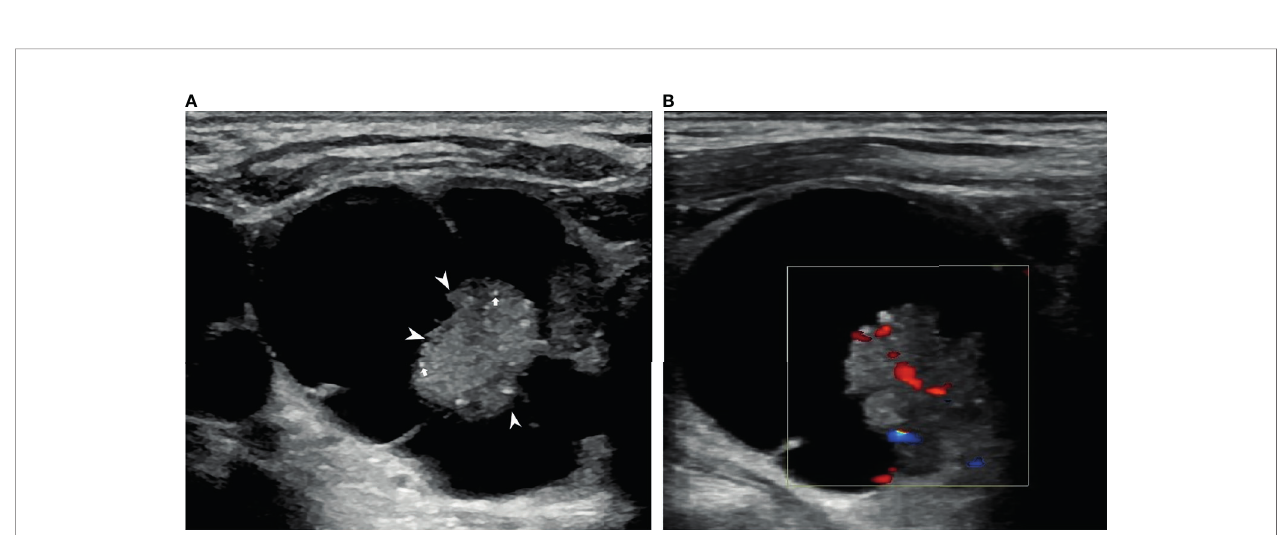
FIGURE 2 | An example of a PCTN with a concentric solid position in a 76-year-old man. Transverse ultrasound (US) image of a 3.43×3.10 cm nodule with internal solid composition (size of 1.49×1.44 cm) showing non-smooth free-margin (arrowheads) and multiple micro-calci fi cations (arrows) (A) . CDFI showing internal fl ow inside the solid component (B) . Papillary thyroid carcinoma was diagnosed by fi ne needle aspiration (FNA) and con fi rmed by surgical histopathology.